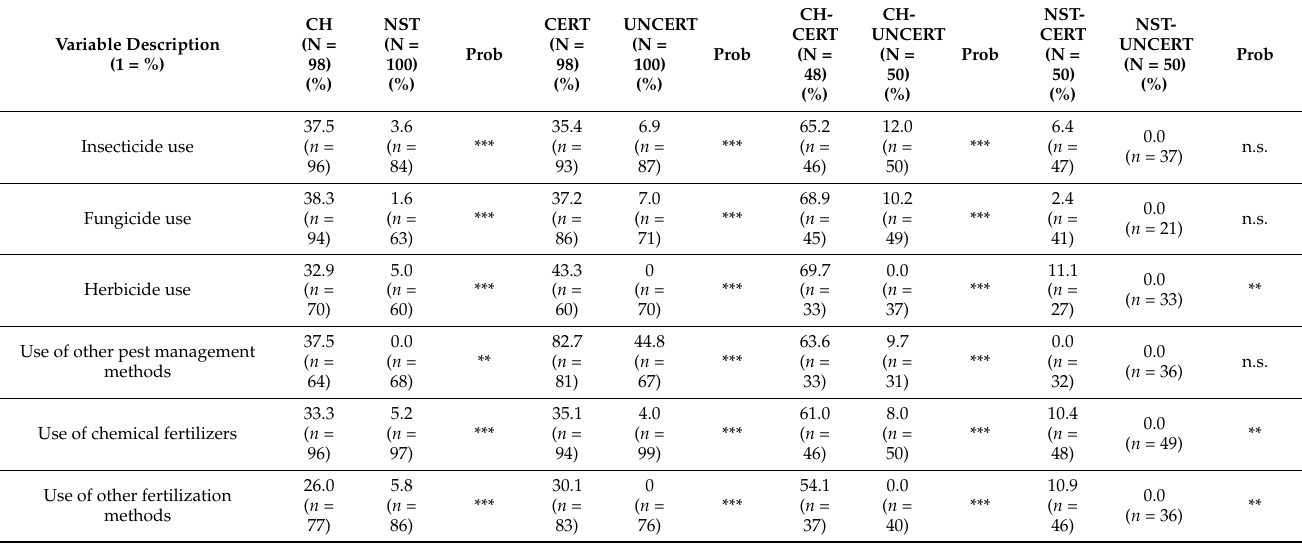
Table 10. Respondent farmers’ record-keeping of agrochemical